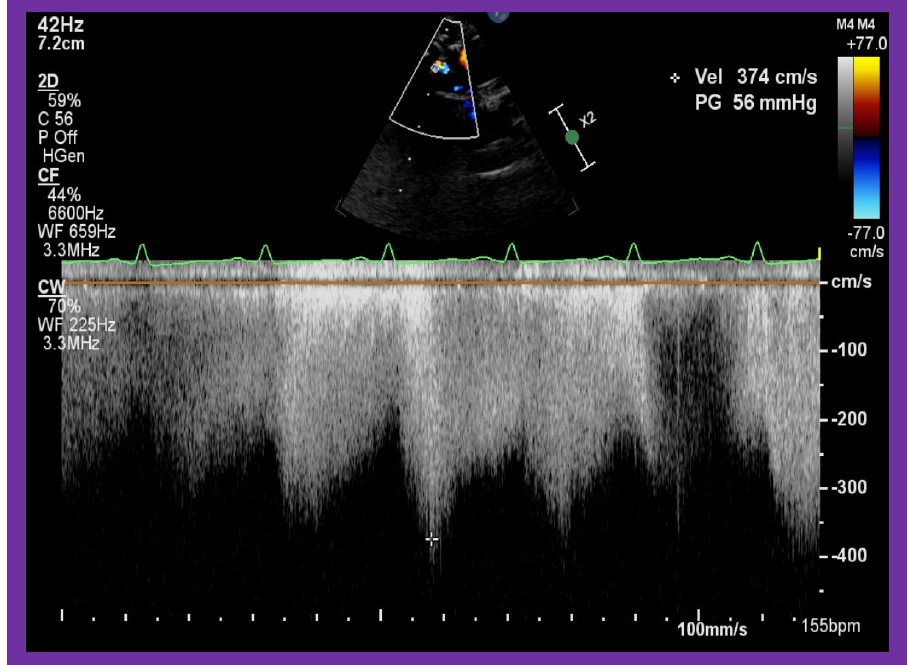
Figure 20. Selected video frames from suprasternal notch view demonstrating high Doppler flow